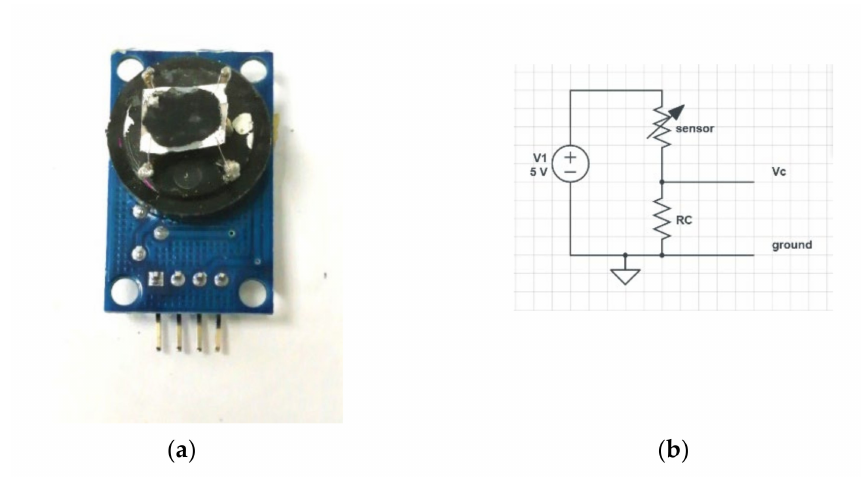
Figure 5. ( a ) MWCNT-based sensor and ( b ) the corresponding electrical circuit. The signal due to an increase in sensor resistance was detected on a pin Vc.